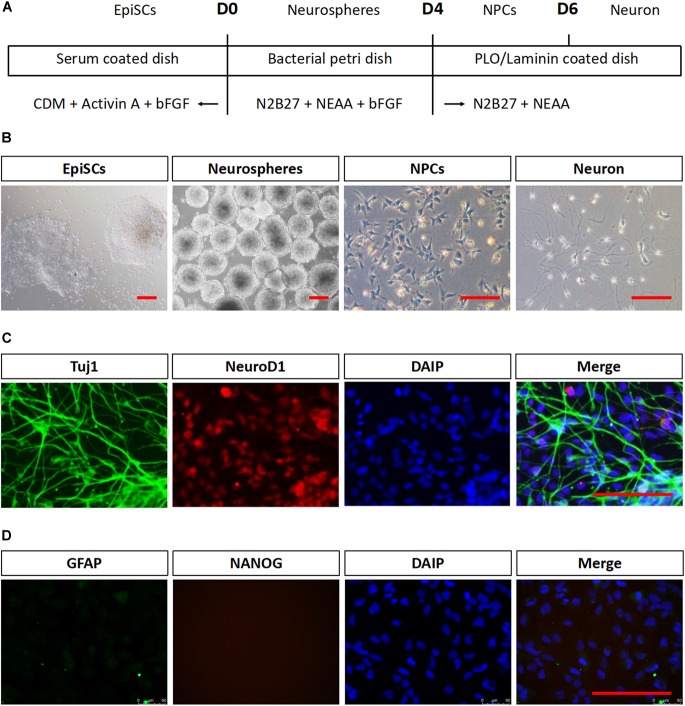
Neuronal differentiation in vitro of mEpiSCs. mEpiSCs were allowed to form neurospheres in suspension, which were dissociated and plated on poly L-ornithine/laminin-coated plates, resulting in early neural cells. (A) Scheme depicting the differentiation experiment workflow. (B) Morphology of mEpiSCs colonies, neurospheres formed following incubation in differentiation media for 4 days, neural progenitor cells, and early neurons. (C,D) Immunofluorescence staining for Tuj1, NeuroD1, GFAP, and Nanog in mEpiSCs-derived early neurons. Tuj1 and NeuroD1 were positive, whereas GFAP and Nanog were negative. Scale bar: 100 μm.